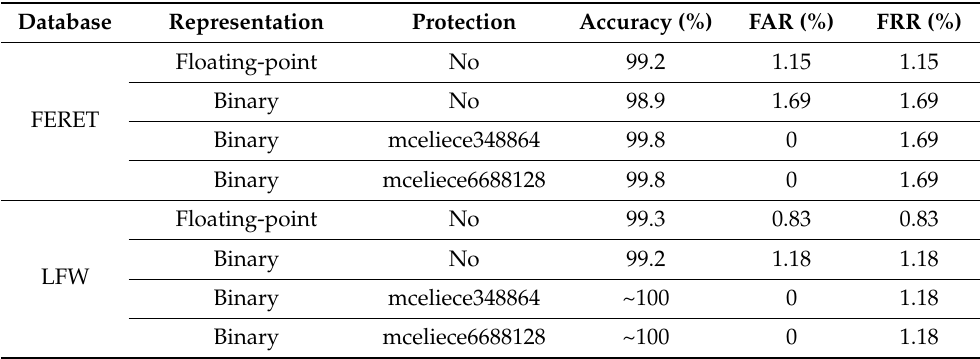
Table 1. Recognition performance of FaceNet embeddings.